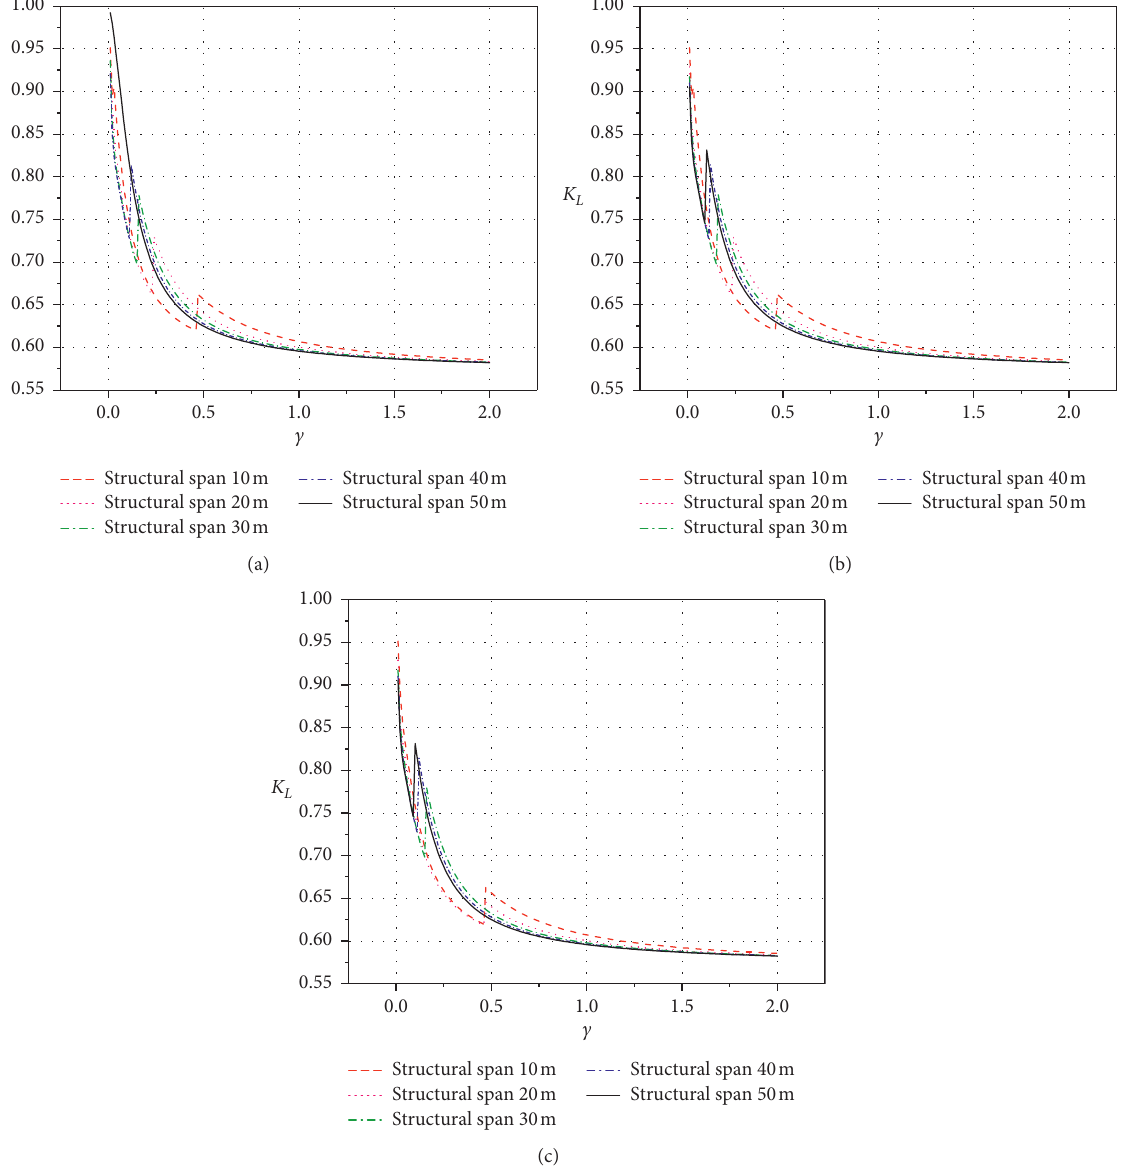
Figure 10: Equivalent load transformation factors of simply-fixed one-way members using Henrych’s formula parameters: (a) W � 1kg. (b) W � 10kg. (c) W �